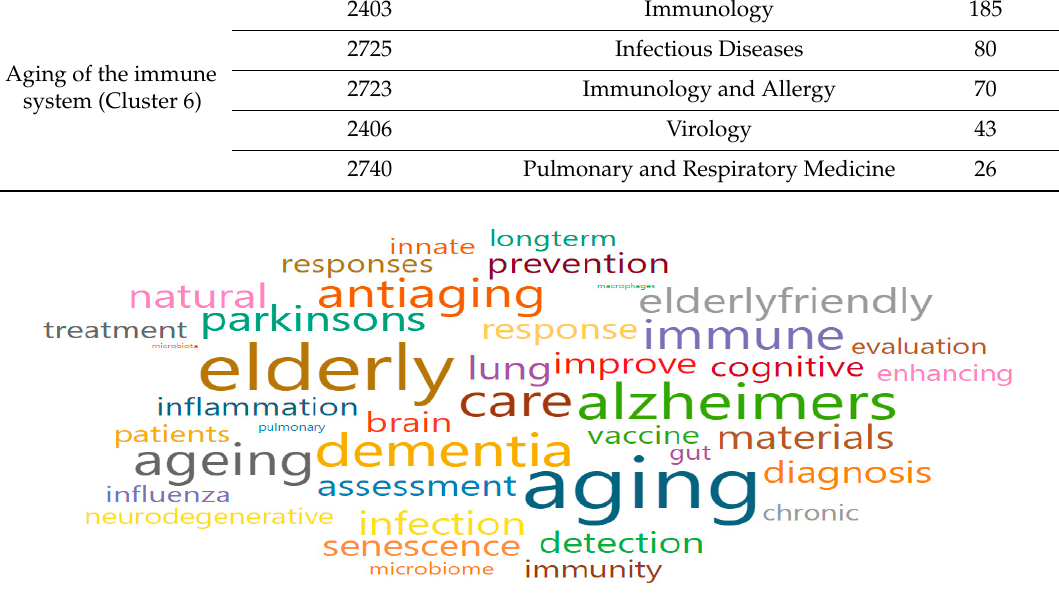
Figure 11. Words cloud in Aging of the immune system (Cluster 6).